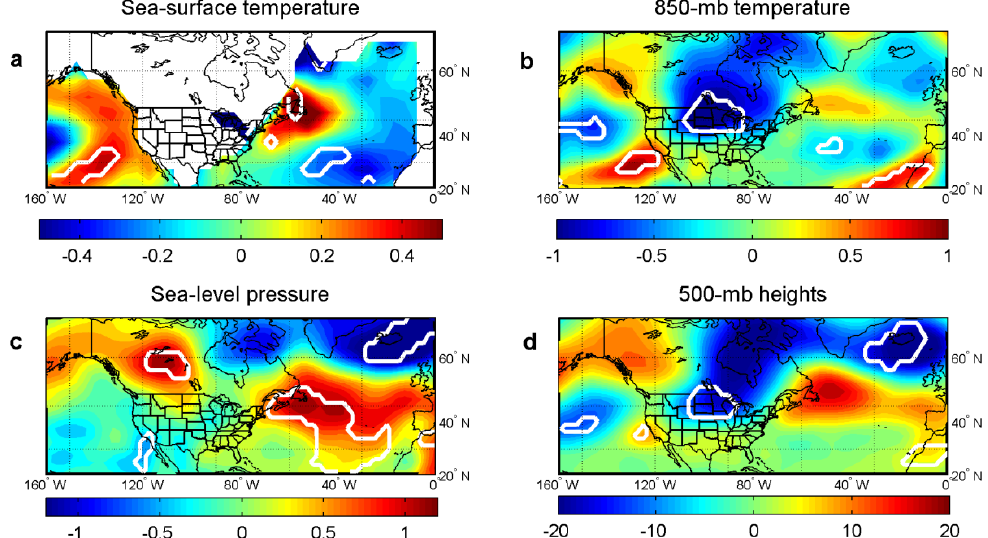
Figure 12. Composite differences between the 12 years with the greatest increase and 12 years with the greatest decrease of summertime (JJA) lake-level change, for high-pass filtered seasonal anomalies of ( a ) SSTs; ( b ) 850-mb temperatures; ( c ) SLPs, and ( d ) 500-mb geopotential heights, for 1949–1998. Areas encompassed by white lines indicate significant differences at the 5%